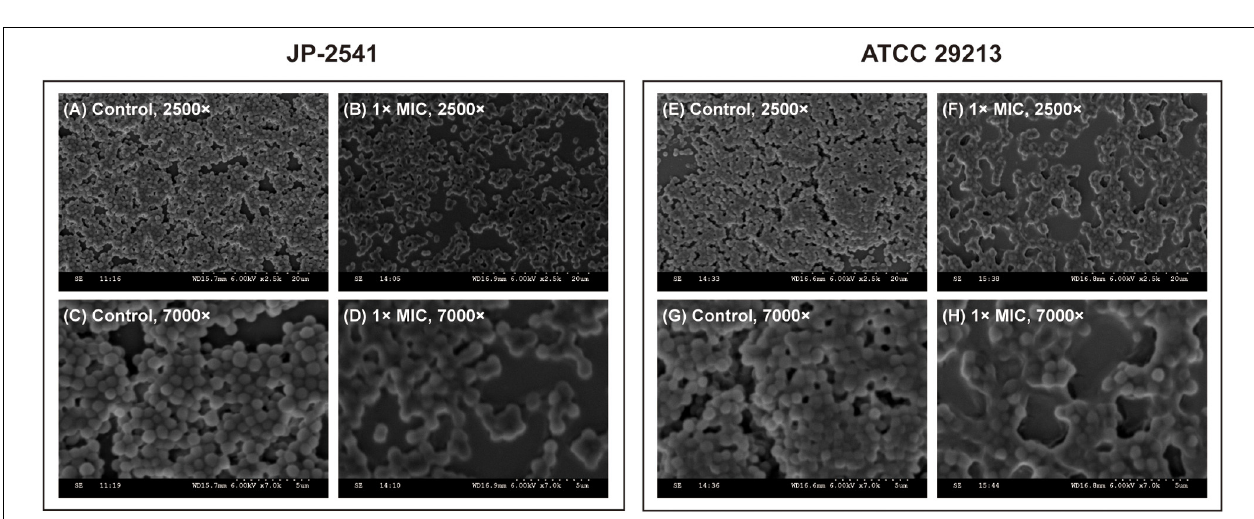
FIGURE 4 | Scanning electron microscope (SEM) images of JP-2541 and S. aureus ATCC 29213 after treatment with CDB. (A) control group of JP-2541, 2,500 × magnification; (B) 1 × MIC CDB against JP-2541, 2,500 × magnification; (C) control group of JP-2541, 7,000 × magnification; (D) 1 × MIC CDB against JP-2541, 7,000 × magnification; (E) control group of S. aureus ATCC 29213, 2,500 × magnification; (F) 1 × MIC CDB against S. aureus ATCC 29213, 2,500 × magnification; (G) control group of S. aureus ATCC 29213, 7,000 × magnification; and (H) 1 × MIC CDB against S. aureus ATCC 29213, 7,000 ×